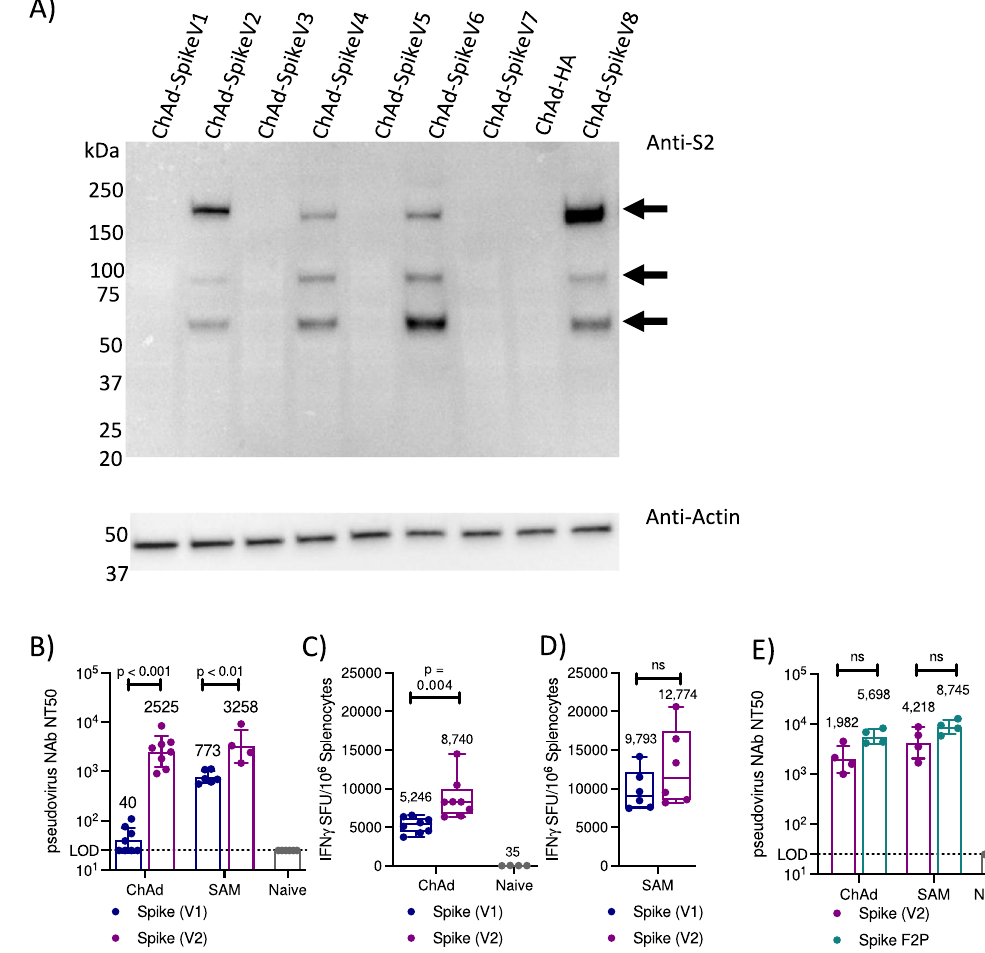
Fig. 1 Codon optimization of spike sequence increases antigen expression in vitro and immune response in mice. A Expression analysis of 8 codon- optimized spike ChAd vaccine vectors (V1 – V8), assessed by Western blot 40 h post infection in HEK293F cells using an anti-spike S2 antibody. A ChAd- in fl uenza HA construct served as a negative control. Arrows indicate full-length spike and S2 cleavage products. Samples were run on a second gel in parallel and an anti-Actin antibody was used to con fi rm equivalent protein loading for all samples. Representative data from one of 3 repeat experiments. B Serum pseudovirus nAb titers in female Balb/c mice 8 weeks post single immunization with either ChAd (1 × 10 11 VP) or SAM (10 μ g) encoding either the spike V1 ( n = 8 for ChAd, n = 6 for SAM) or V2 sequence ( n = 8 for ChAd, n = 4 for SAM). Mice were immunized and sera collected separately for each vaccine, samples were assessed by validated pseudovirus neutralization assay. Naive samples all below LOD (LOD = 25). Geometric mean (annotated) and geometric SD, two-tailed Mann – Whitney test ( p = 0.000155 for ChAd and p = 0.009524 for SAM). C Spike-speci fi c T-cell response assessed by IFN γ ELISpot (sum of eight pools) in Balb/c mice. Splenocytes collected 2 weeks post immunization with ChAd (1 × 10 11 VP) encoding either the spike V1 or V2 sequence ( n = 8/group). D Spike-speci fi c T-cell response assessed by IFN γ ELISpot (sum of two pools) in Balb/c mice. Splenocytes collected 2 weeks post immunization with SAM (10 μ g) encoding either the spike V1 or V2 sequence ( n = 8/group). C , D Box and whiskers represent median, IQR and range. Mean annotated, p -value determined by two-tailed unpaired Student ’ s t -test. Note that data in ( C ) and ( D ) are from separate studies. E Pseudovirus nAb titers in mouse sera 8 weeks post immunization with ChAd (1 × 10 11 VP) or SAM (10 μ g) encoding the speci fi ed spike variant. Geomean (annotated) and geometric SD. All mice immunized and assessed together, representative data from one of three studies. Sera from Naive mice were below LOD of 25. Two-tailed Mann – Whitney